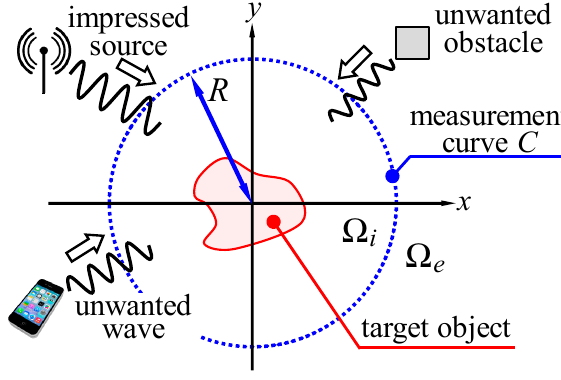
Figure 1. Image of the main issues addressed here.